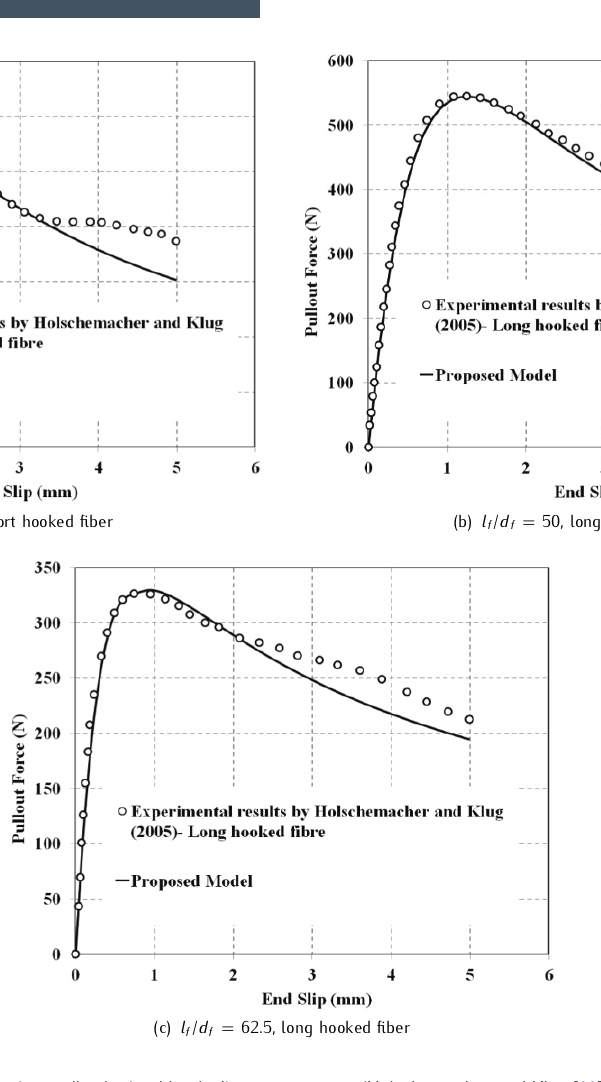
Figure 8. Comparison of the experimentally obtained load–slip curves versus (Holschemacher and Klug [28]) predicted curves by using the proposed model.